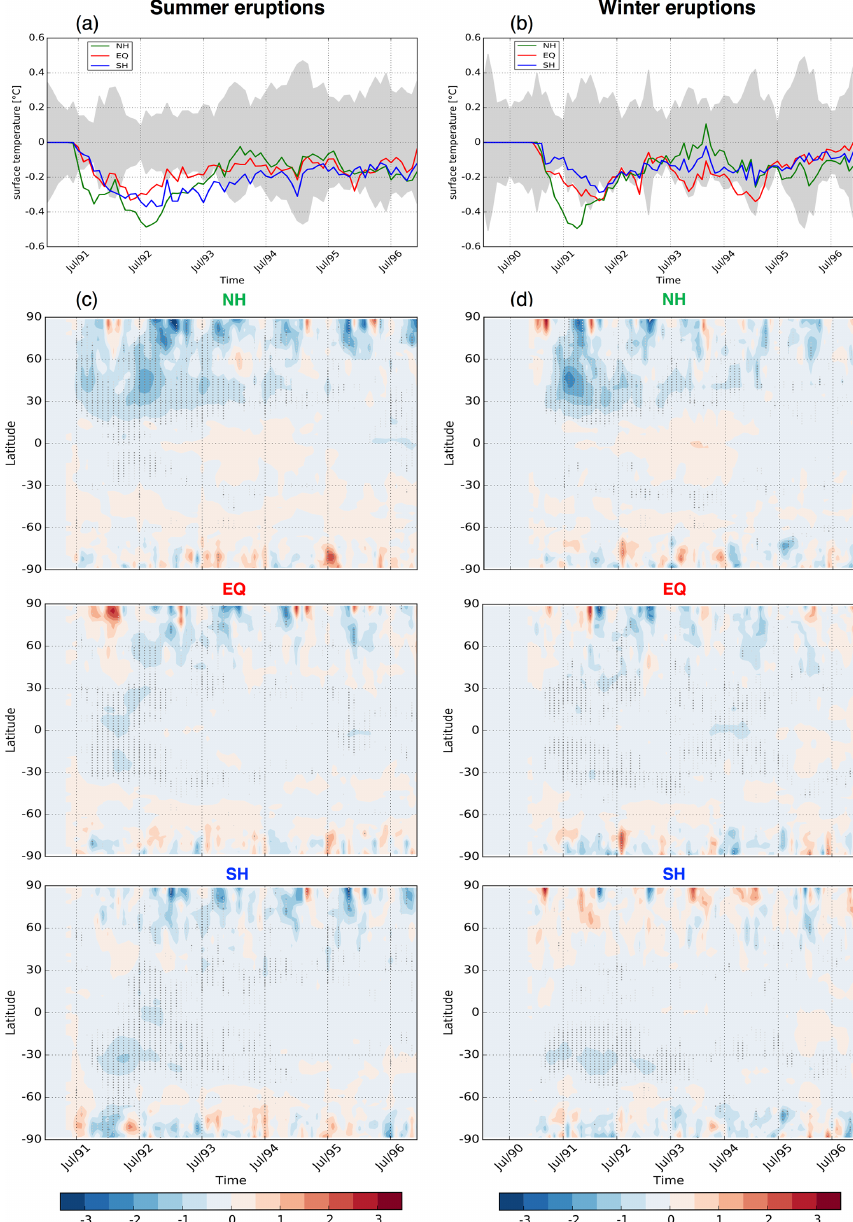
Figure 3. Global mean surface temperature ( ◦ C) anomaly for the summer (a) and winter (b) volcanic eruption cases and their zonal mean distributions (c, d) . The grey shading in (a) and (b) indicates 2 standard deviations around the mean of the control runs without any volcanic eruption. Dark grey and light grey stippling in (c) and (d) indicate the grid points with significant differences based on the two-tailed Student’s t test at the 95% and 99% confidence level,